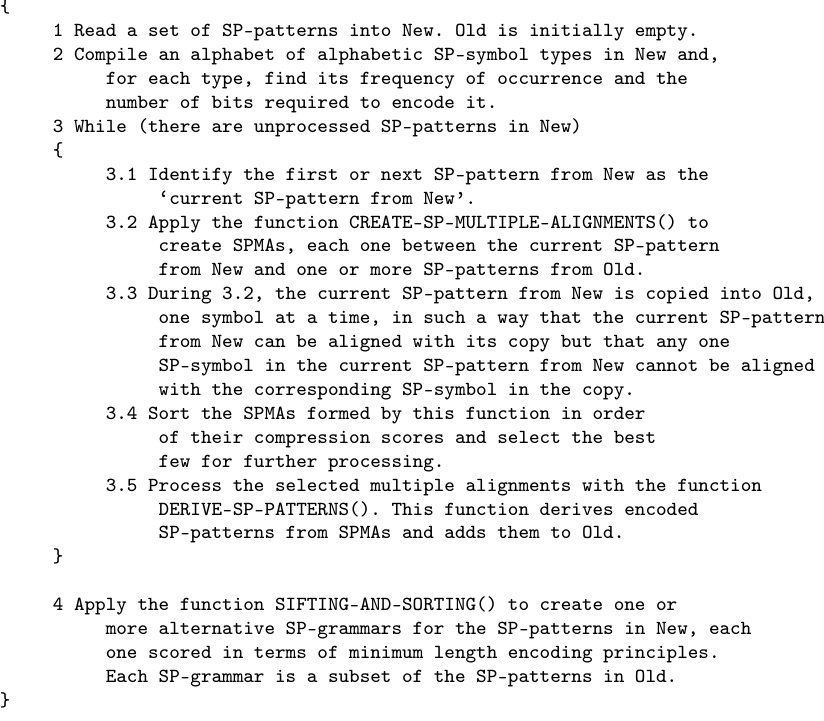
Figure 1. The organisation of unsupervised learning in the SPCM. The workings of the functions CREATE-SP-MULTIPLE-ALIGNMENTS(), DERIVE-SP-PATTERNS() and SIFTING-AND-SORTING() are explained in ([2], Chapter 9). Adapted from Figure 9.1 in